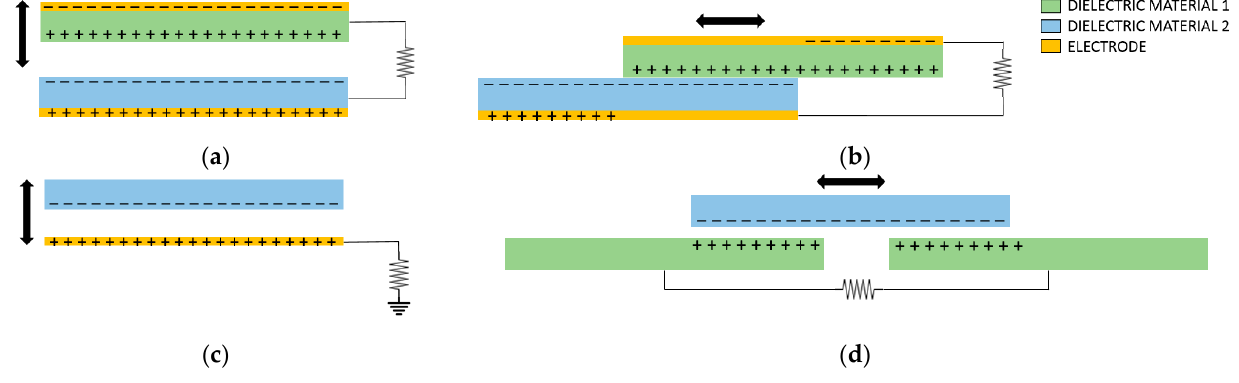
Figure 1. Four basic modes of work of a TENG: ( a ) vertical contact-separation mode; ( b ) lateral-sliding mode; ( c ) single-electrode mode; ( d ) free-standing mode.